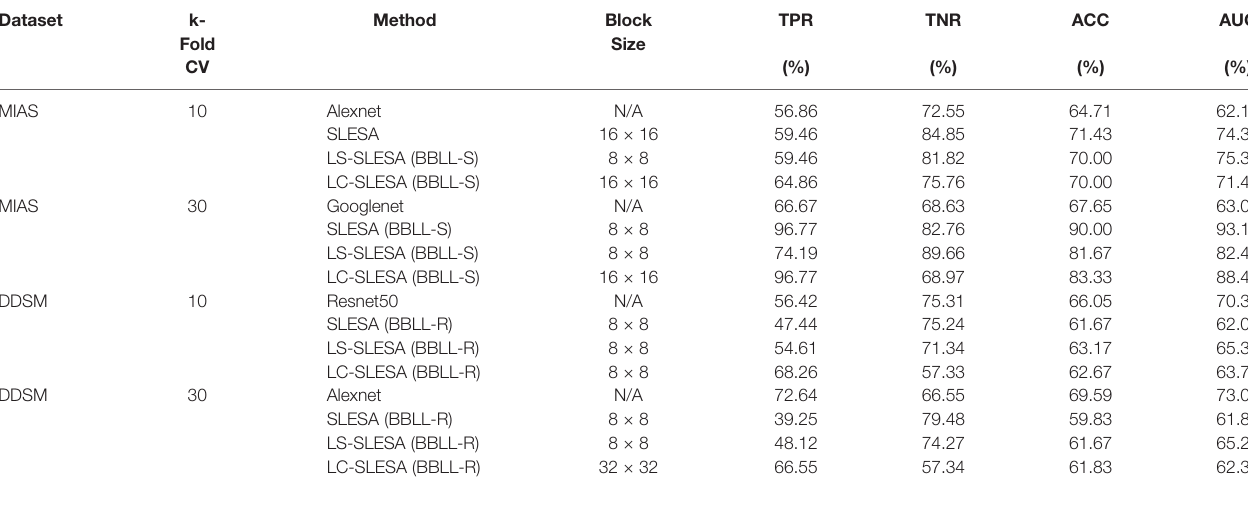
TABLE 5 | Top AUC performances of sparse analysis and deep learning methods on MIAS and DDSM datasets. Dataset k-